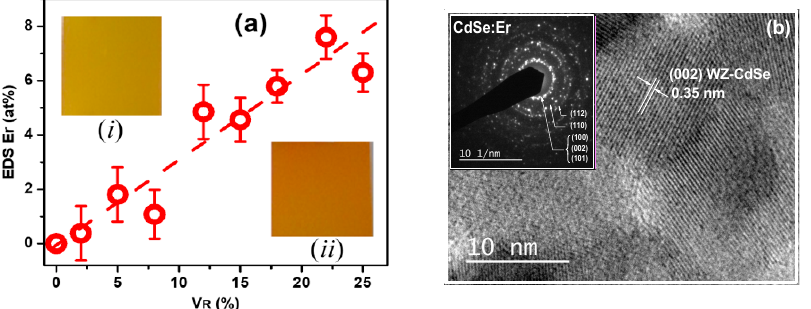
Figure 1. ( a ) EDS as a function of V R . Dashed line represents a linear fitting. (i) and (ii) insets illus- trate images of the V R = 15% doped and undoped Cd 1- x Er x S samples, respectively. ( b ) TEM image of sample for x = 4.6 at%, where the (002) planes of wurtzite phase of CdSe are represented. The inset shows a SAED pattern of the WZ crystalline structure.